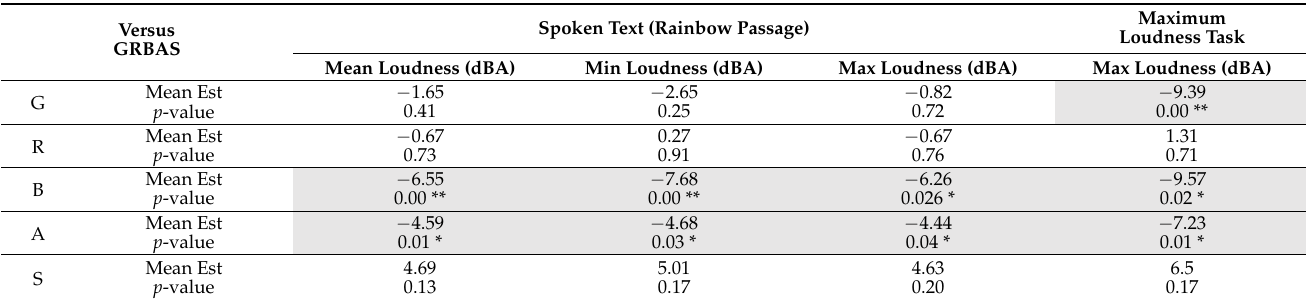
Table 6. Relationship between acoustic voice data from spoken text and maximal loudness tasks and consensus ratings from GRBAS scale, controlled for age at assessment and